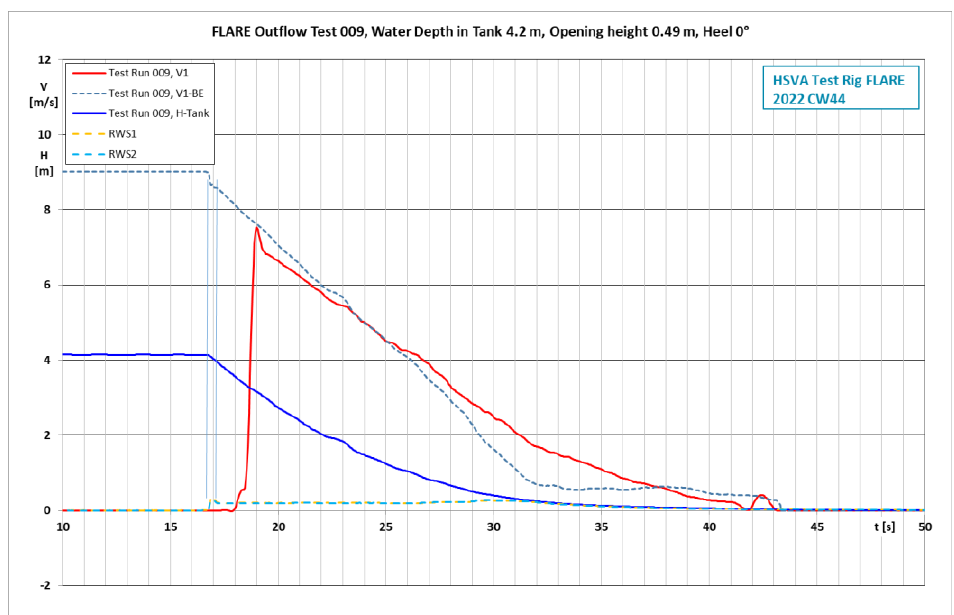
Figure A3. Flow speed V 1 and water elevations RWS1 and RSW2 at the first section S 1 for the test run 009.